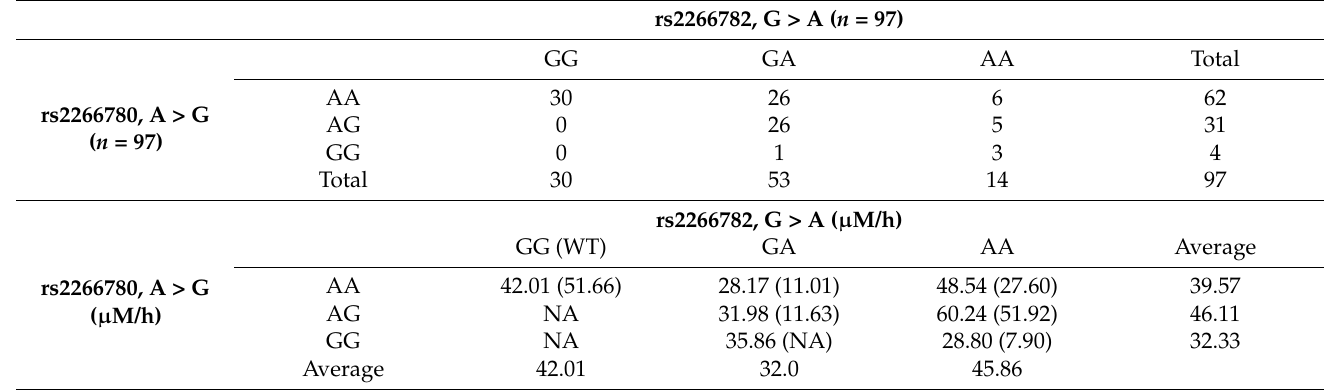
Table 4. Distribution of FMO3 genotype and AUC-TMAO by genotype. Distribution of genotypes at two common SNPs in the FMO3 gene ( top ) and total AUC-TMAO ( µ M/hour) over the 6 h postprandial window ( bottom ). Values are counts ( top ) and means (standard deviation) ( bottom ). rs2266782, G > A ( n =